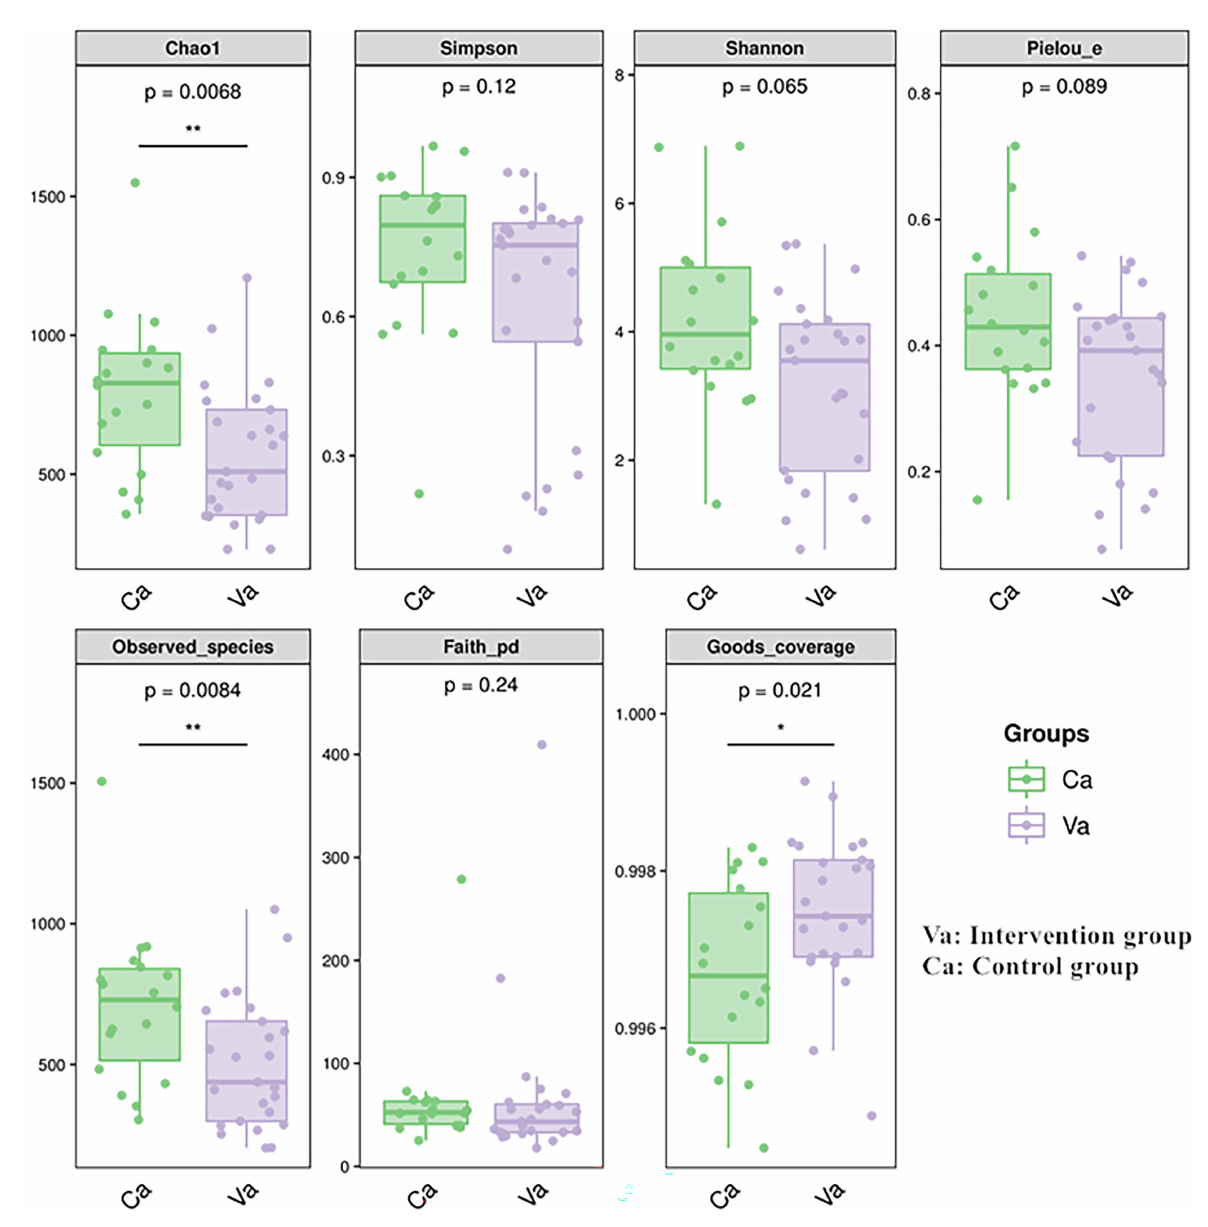
of the body ’’ s total blood, and it is signi fi cantly affected by reduced blood supply (Takala, 1996). During the heart failure process, the gut is the fi rst organ to undergo ischaemia and the last organ to recover. Intestinal ischaemia or hyperaemia reduces the intestinal oxygen supply, which can lead to changes in